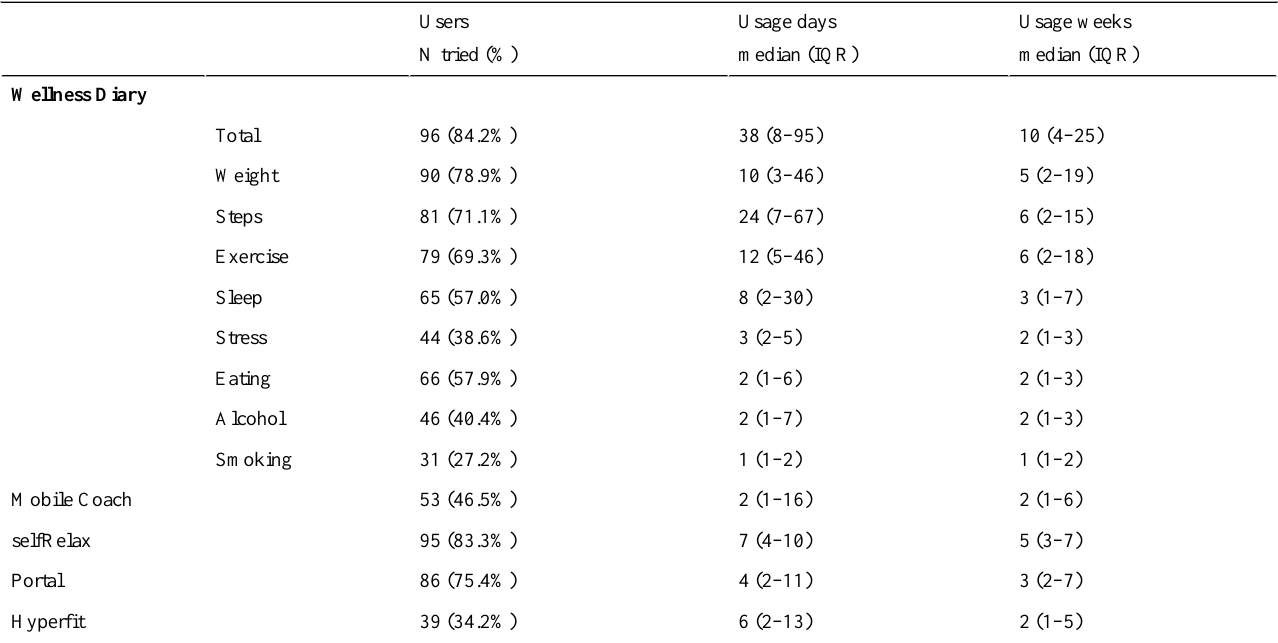
Table 2. Users and usage days and weeks for mobile applications, self-monitoring variables and Web services based on logs, presented as median (IQR), for the subjects who tried the technology at least once.